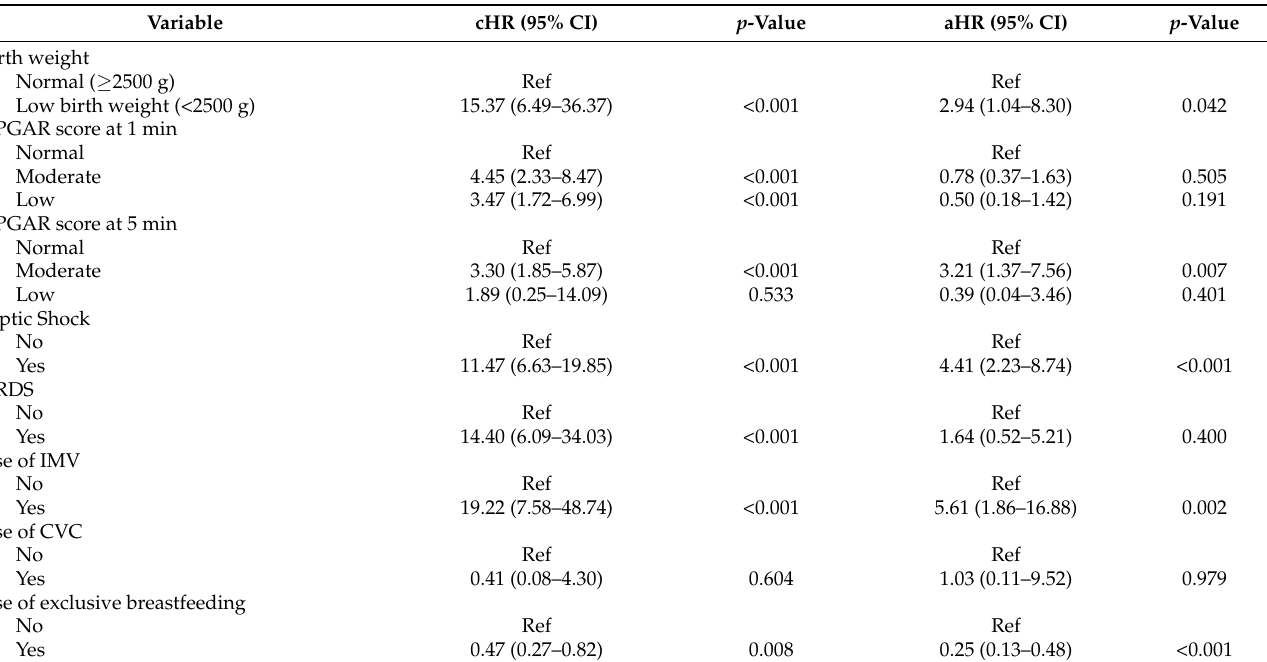
Table 4. Cox regression to find clinical predictors clinical of mortality in patients with neonatal